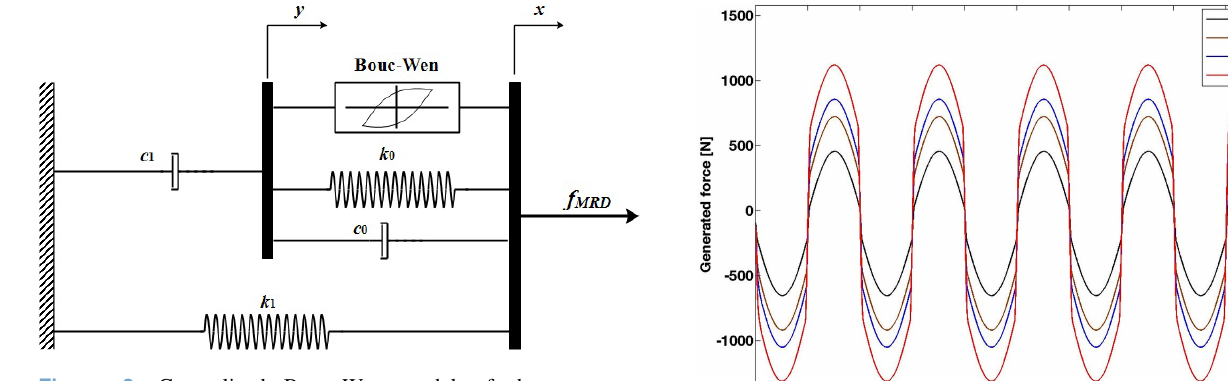
Figure 2. Generalized Bouc–Wen model of the magneto- rheological damper.